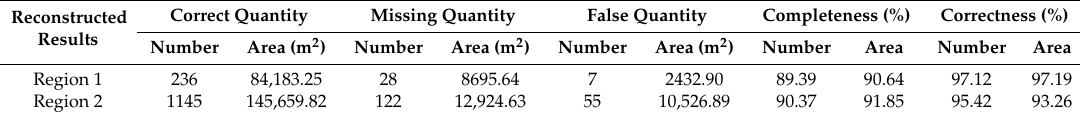
Table 2. Correctness and completeness of the reconstructed buildings’ rooftop